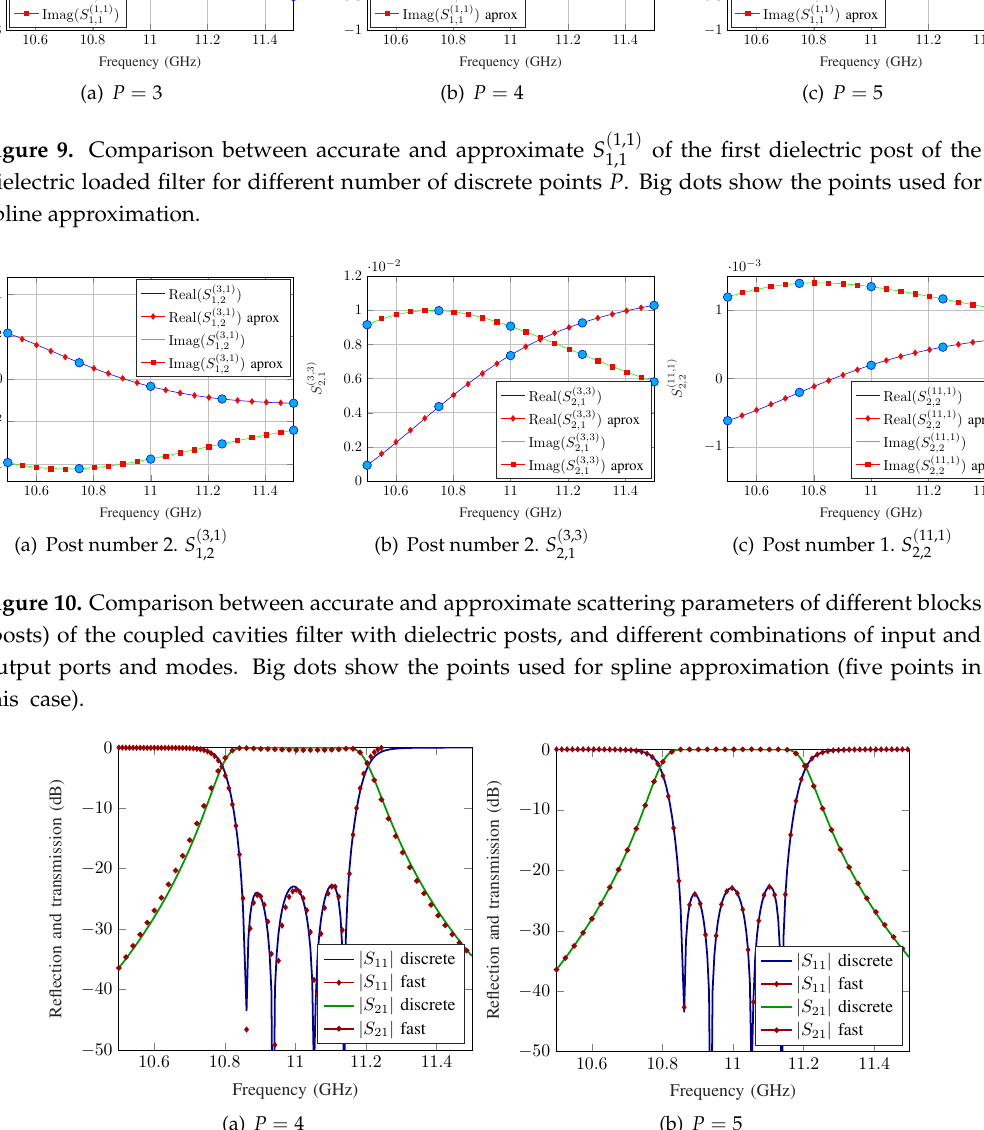
Figure 11. Comparison of the frequency response with fast and discrete sweep for the dielectric loaded filter with P = 4 and P = 5 points for the spline